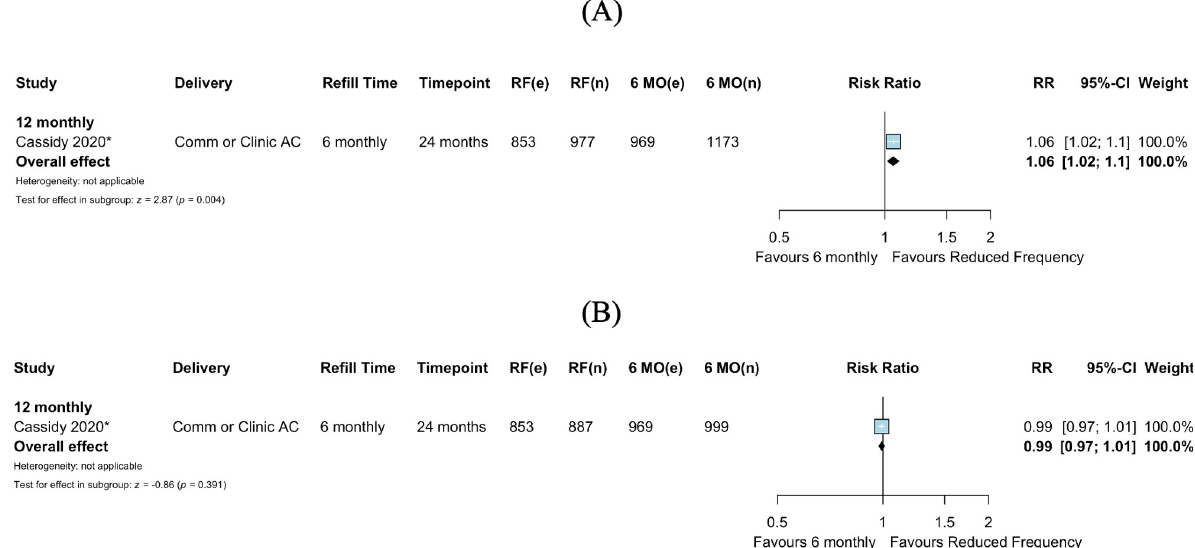
Fig 5. Viral suppression: Reduced frequency versus 6-monthly clinical consultations. (A) Among those randomized. (B) Among those with viral load testing. � Cluster-adjusted RR. 6 MO, 6-monthly; AC, adherence club; Comm, community; e, number of events; n, number of participants; RF, reduced frequency; RR, risk